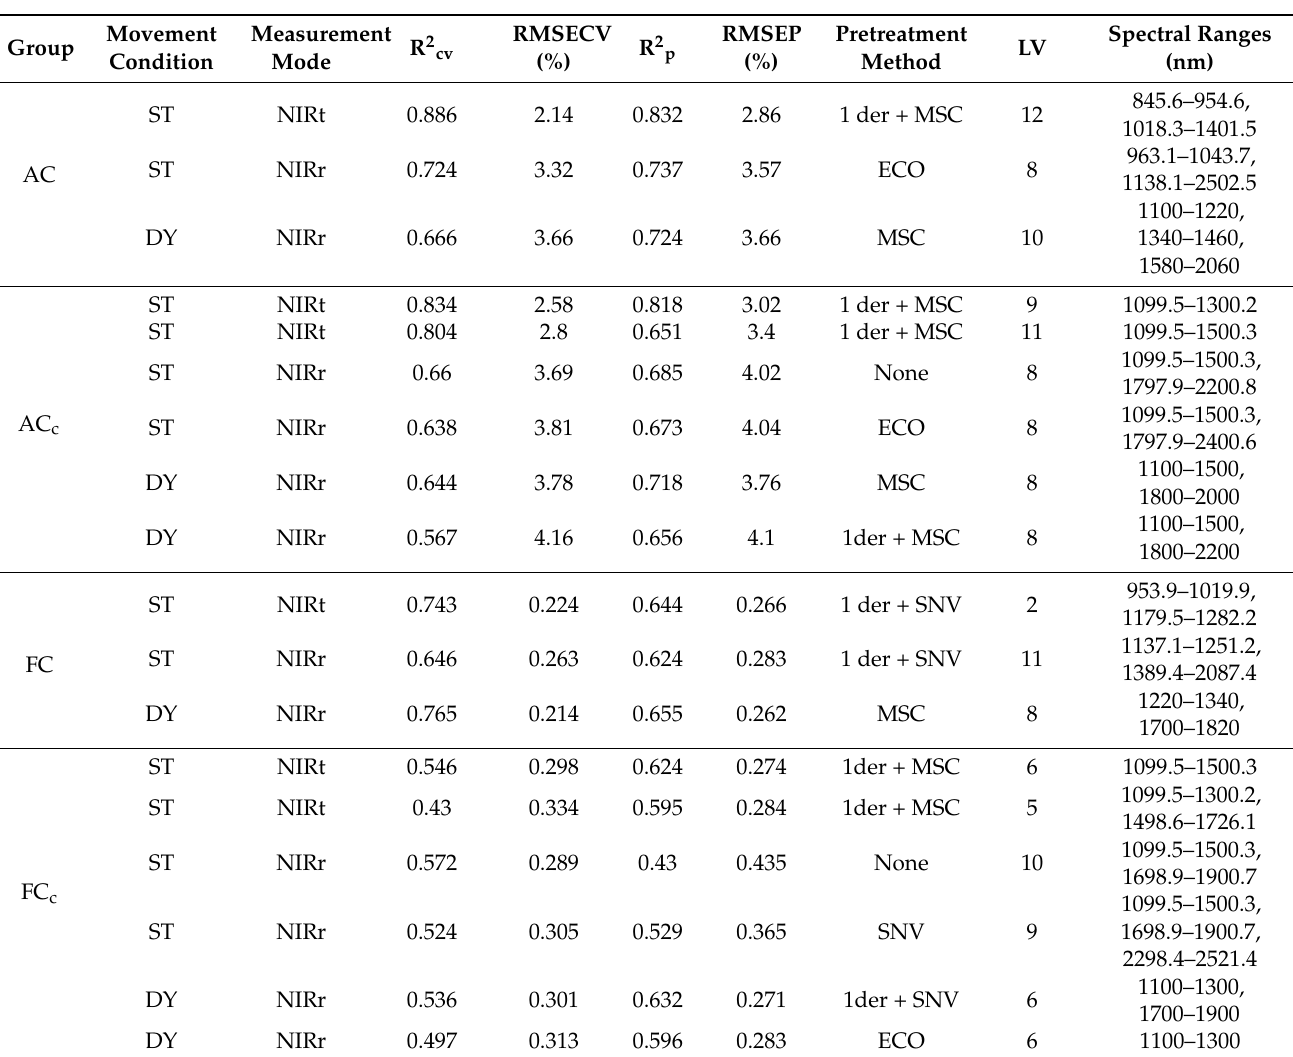
Table 2. The calibration and validation results of the PLS models for AC and FC in single rice